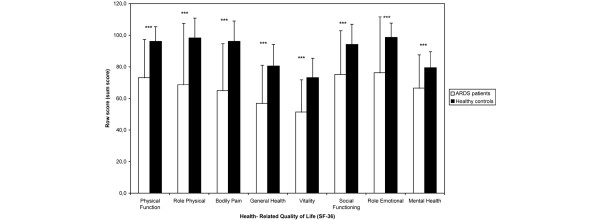
Subdimensions of health-related quality of life. Subdimensions of health-related quality of life were measured with the Medical Outcomes Study 36-Item Short Form (SF-36; physical function, physical role function, bodily pain, general health, vitality, social function, emotional function and mental health), comparing between patients with acute respiratory distress syndrome and age- and gender-matched healthy controls. Significant difference (***p < 0.0001) was calculated with t tests for independent samples.